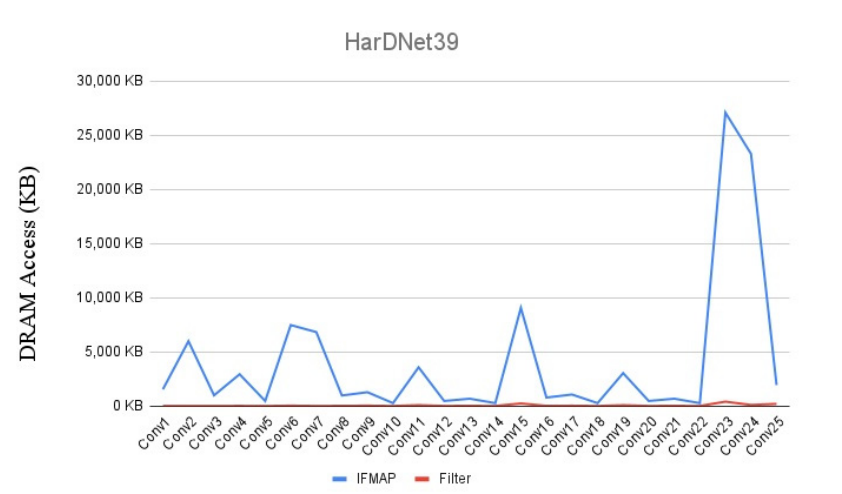
Figure 2. Data size distribution of HarDNet39.